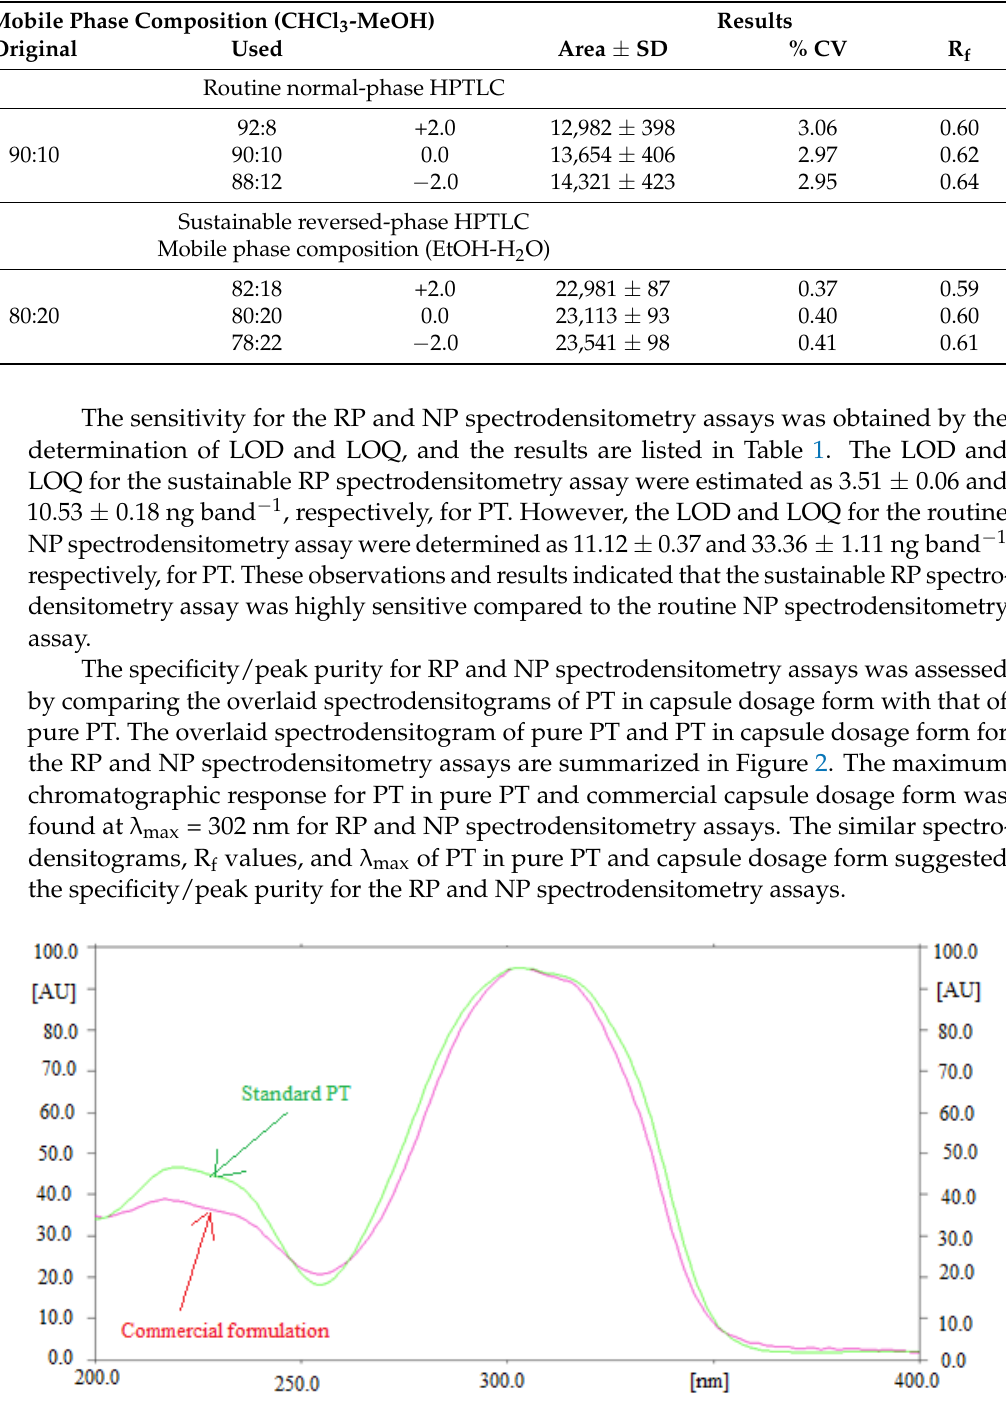
Table 5. Results of robustness analysis after modifying the mobile compositions for the routine normal-phase HPTLC and the sustainable reversed-phase HPTLC techniques (mean ± SD; n = 6). Conc.